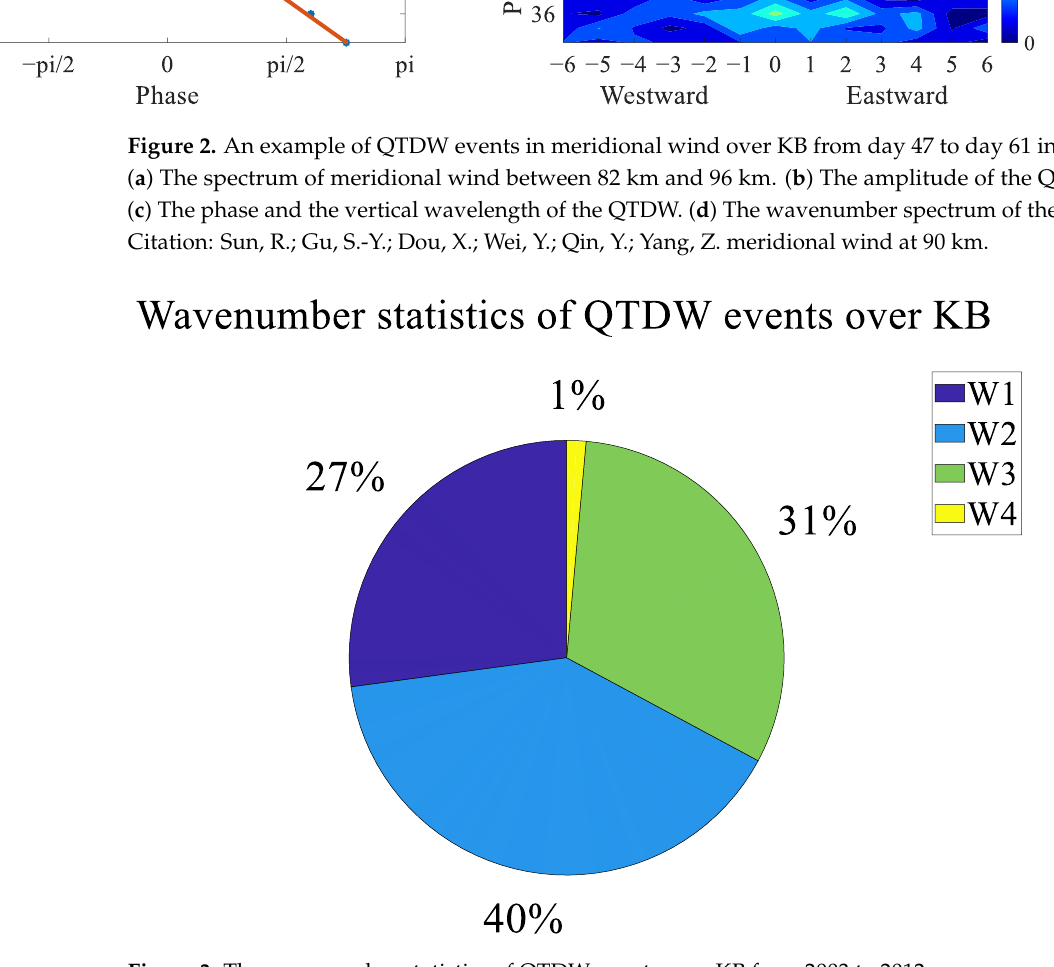
Figure 3. The wavenumber statistics of QTDW events over KB from 2003 to 2012.